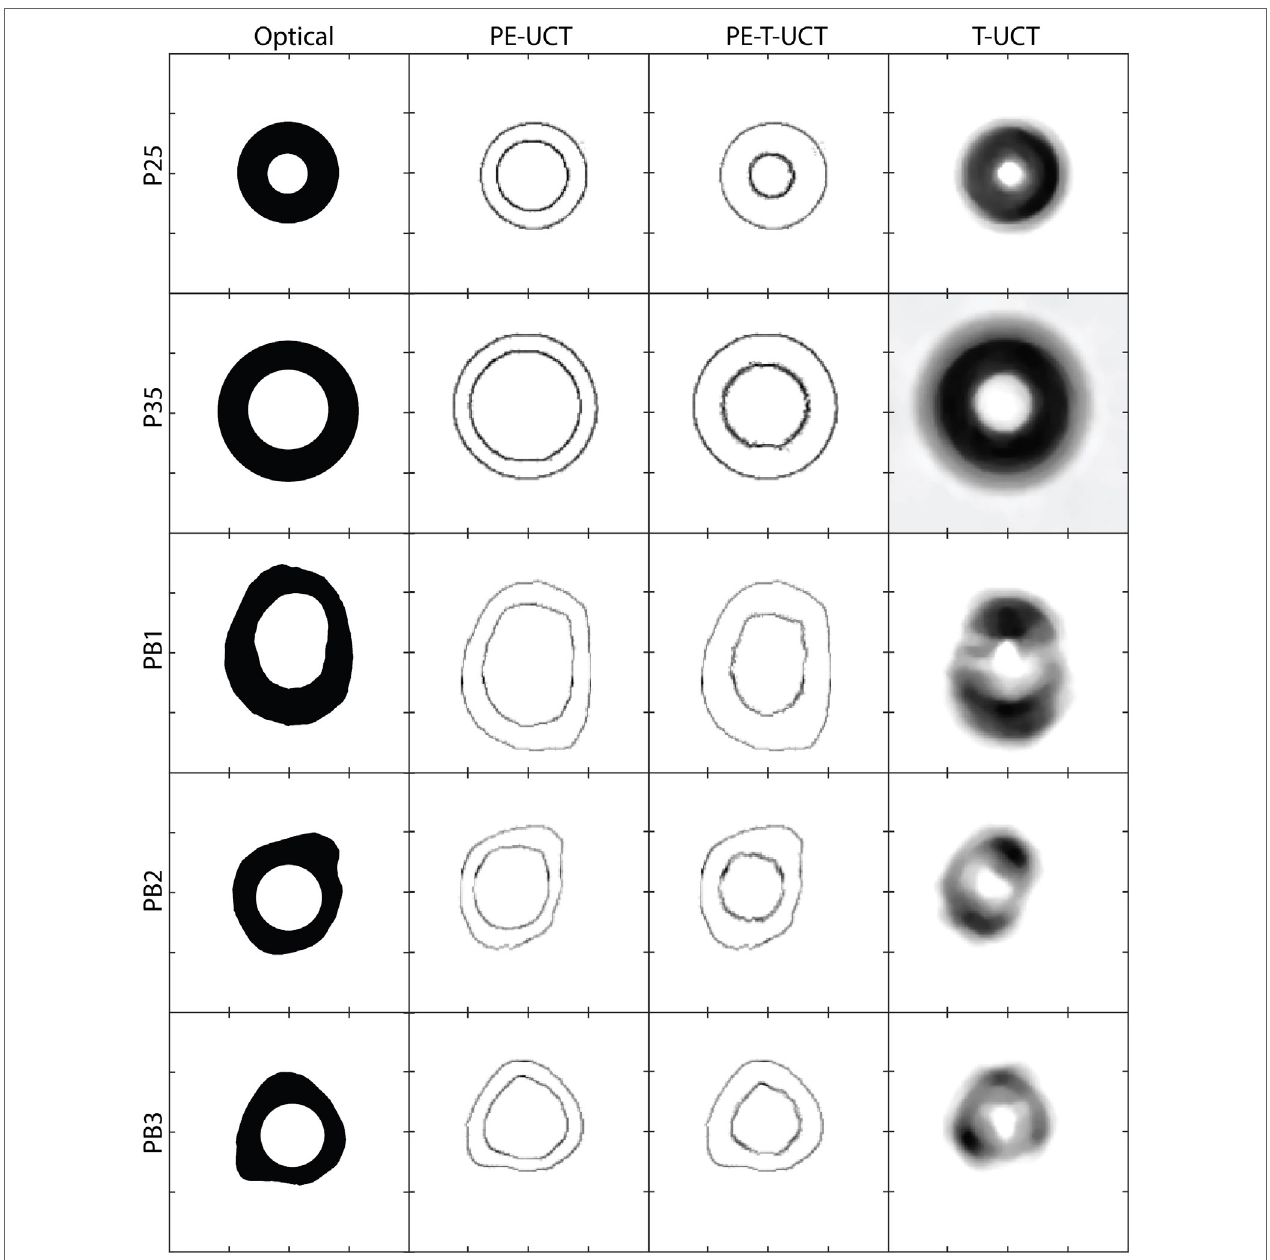
FigUre 4 | From left to right: the sample dimensions from optical micrographs, PE-UCT reconstructions, PE-T-UCT reconstruction, and T-UCT reconstruction. From top to bottom: P25, P35, PB1, PB2, and PB3. The scale is the same for all images which are 60 mm × 60 mm in size and the tick marks are 15 mm apart. PE-UCT, pulse-echo ultrasound computed tomography; T-UCT, transmission ultrasound computed